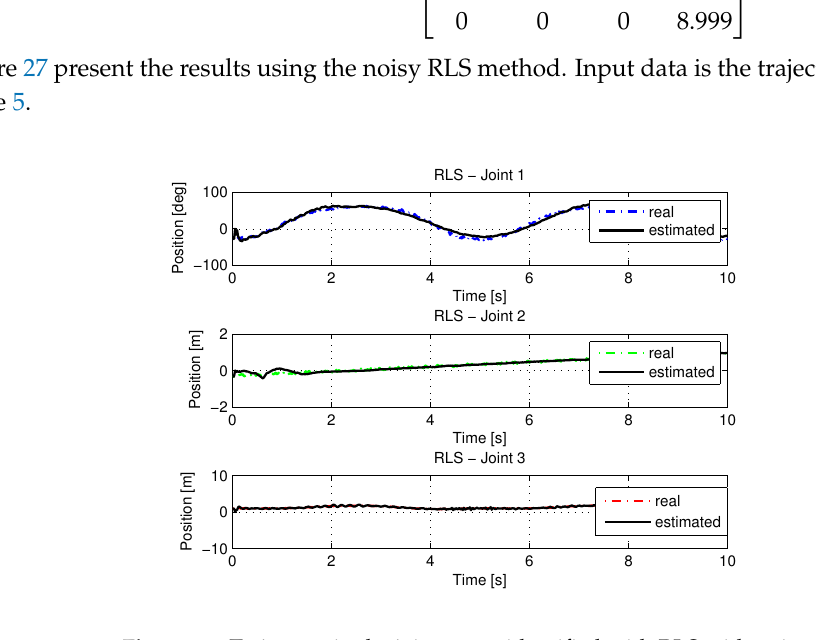
Figure 27. Trajectory in the joint space identified with RLS with noise.